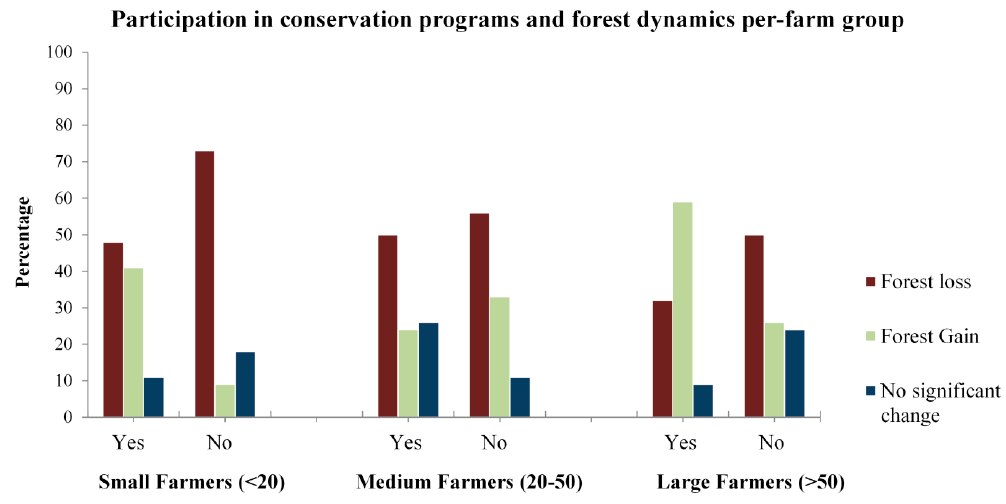
Figure 10. Relationship between conservation programs and forest cover change per-farm type.